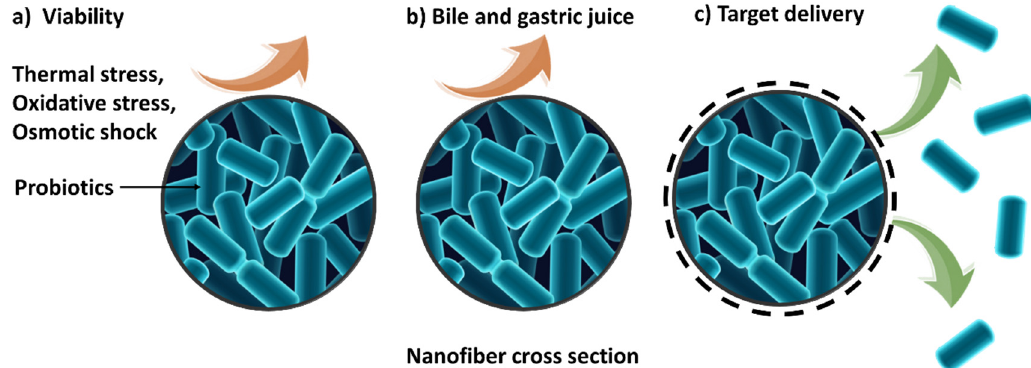
Figure 4. A schematic for the use of electrospun nanofibers in probiotic delivery. Encapsulation in a polymer matrix can ( a ) protect the organisms from external stresses and thus maintain viability during manufacturing and storage, ( b ) protect the probiotics from the bile and stomach acids, and ( c ) permit dissolution of the formulation and release of viable probiotics at the target site. Table 4. A list of probiotics that have been incorporated into electrospun nanofibers, along with the potential applications. Polymer